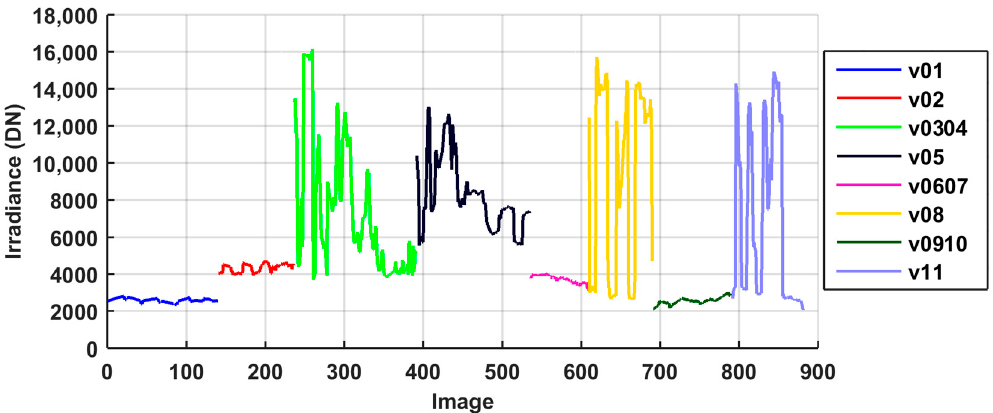
Figure 3. Irradiance recordings during different flights measured using the onboard irradiance sensor.